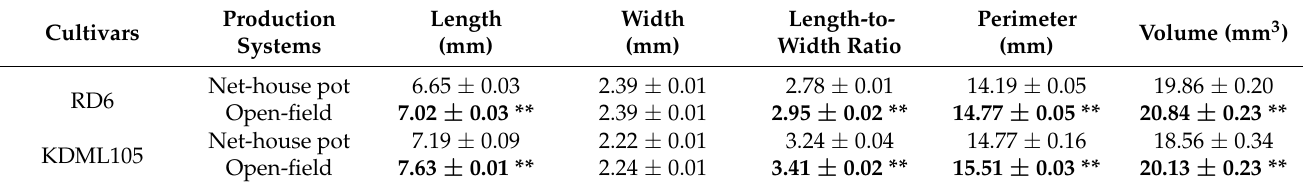
Table 3. Grain morphology of the two elite Thai rice cultivars grown in the net-house pot and open-field production systems.